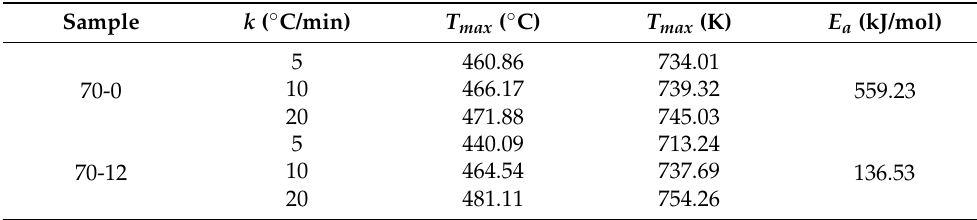
Table 4. Maximum temperature ( T max ) for each heating rate ( k ) and activation energy ( E a ) for 70 wt.% PDMS-MPs composites just after the composite synthesis (70-0) and after 12 weeks